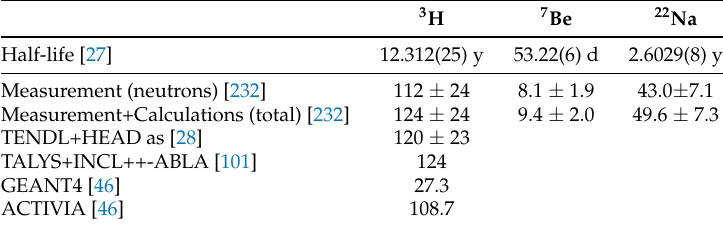
Table 12. Rates of production of long-lived radioisotopes induced in silicon at sea level. Measurements from Ref. [232] and different calculations are presented (see text). All numbers are expressed in